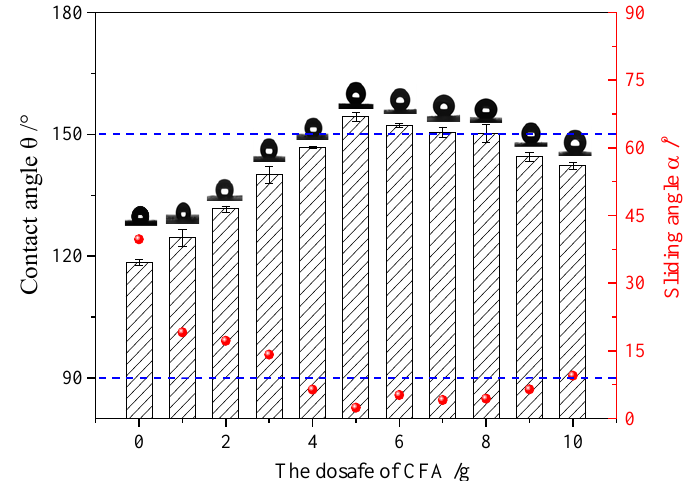
Figure 9. Influence of the UFA dosage on the coating hydrophobicity (bar: contact angle, red dot: sliding angle; 1 mL HFDS, 50 mL ethanol).